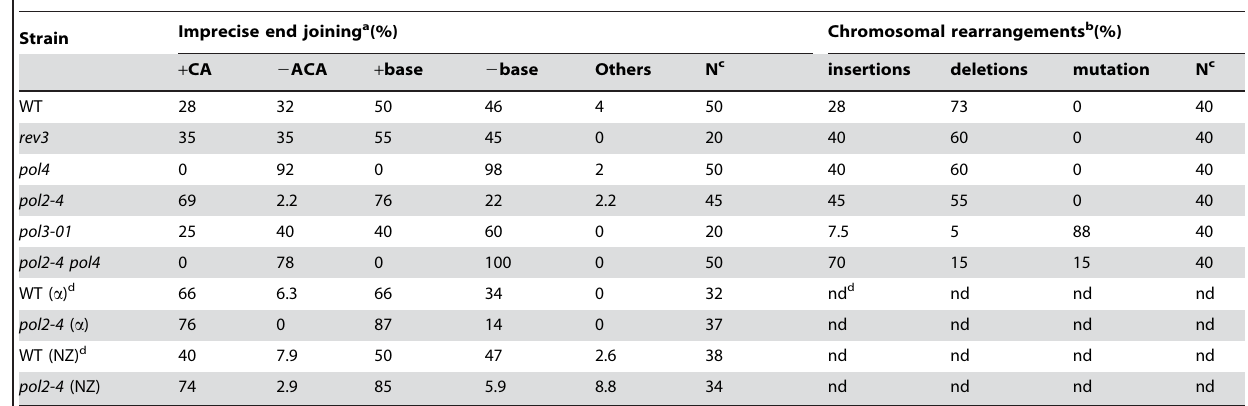
Table 1. Repair patterns after a DSB at the URA3 :: ACT1 intron::HO cut site locus of non-essential DNA polymerase mutants.